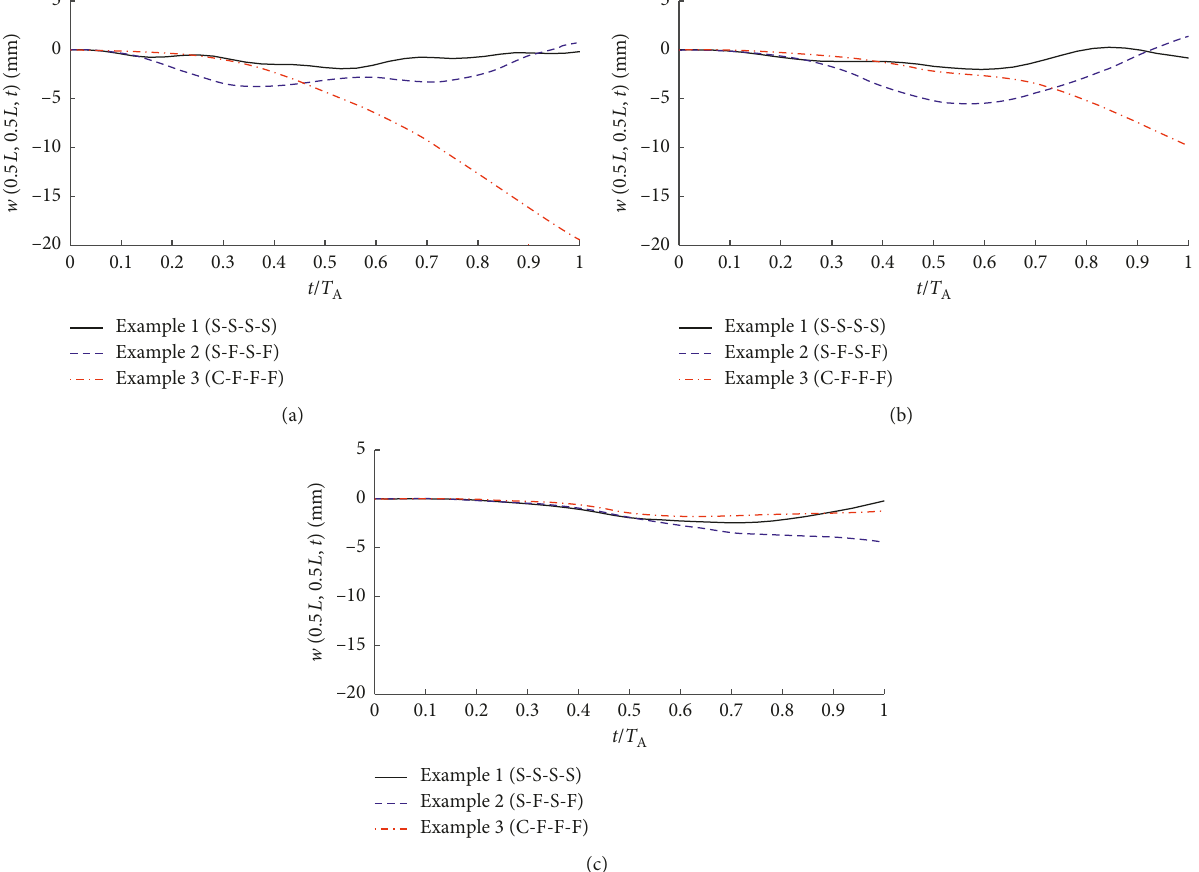
0 on the vibration responses at the center of three square plates when 1m/s, (b) v 0 2 m/s, and (c) v 0 5m/s. (cid:31) (cid:31) (cid:31)